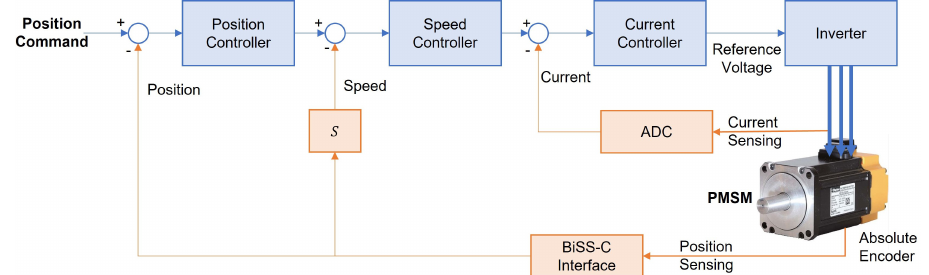
Figure 18. The structure of the serial-controlled